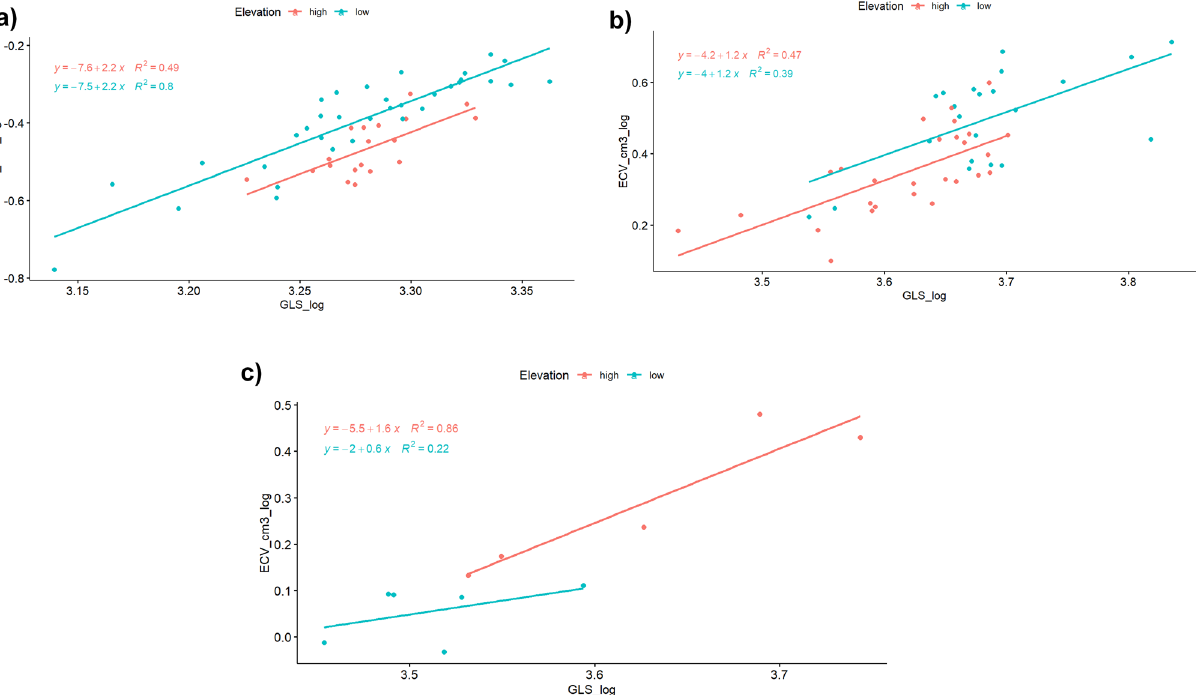
Figure 2. Analysis of co-variance showing regression slopes of log endocranial volume versus log skull length for highland (red) and lowland (blue) ( a ) Peromyscus mice (Cricetidae), ( b ) Muridae (Otomyini), ( c ) Muridae (Praomyini). Since length is proportional to the cube of mass (body size), the allometric exponents for body size the slopes in the above regression coefficients are equivalent to one third of the regression coefficients shown. Thus, the allometric exponents for Peromyscus (0.7 for high and low populations) are higher than those for Otomys (0.4 for high and low species), and Praomyini have different slopes for high (0.5) and low (0.2)